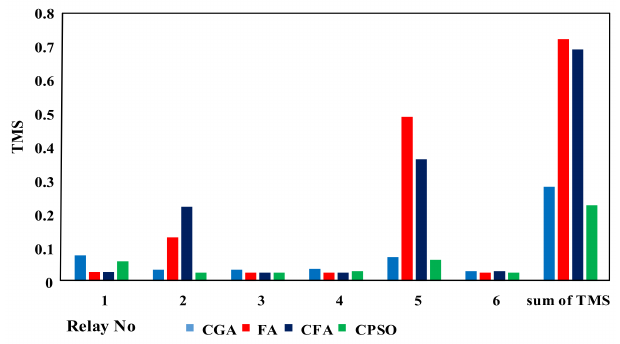
Figure 14. Graphical representation of the optimized TMS compared with the literature for Case IV.